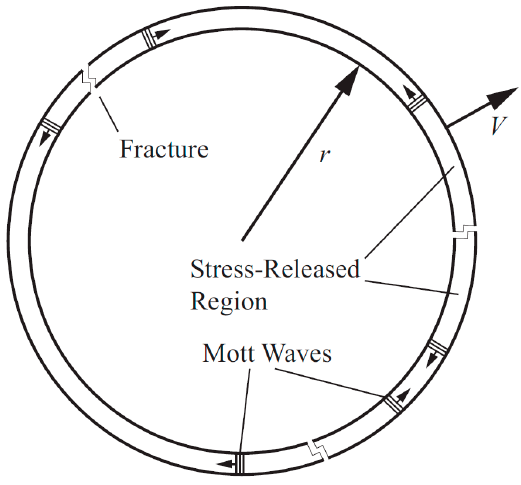
Figure 3. Schematic diagram of the Mott ring.